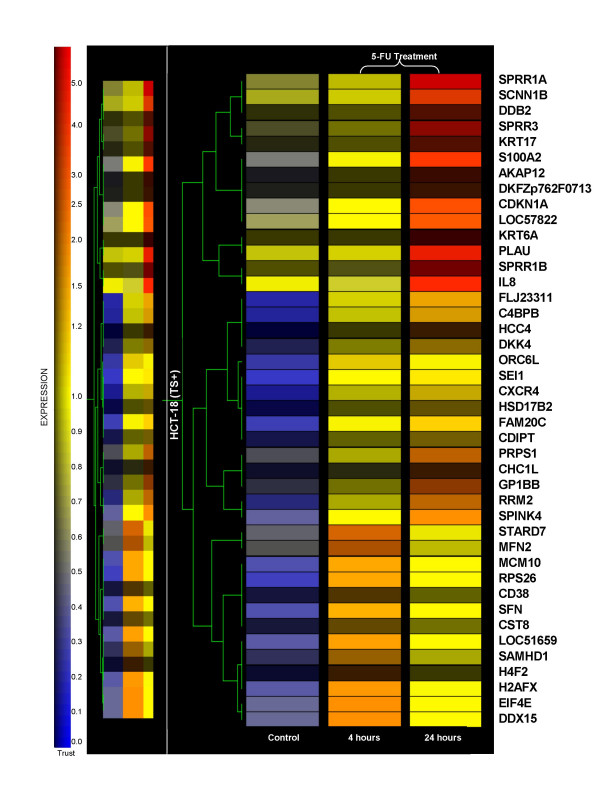
Clustering analysis of TS dependent cytotoxicity in HCT-C18 (TS+) cells (Lane 1) treated with 10 μM 5-FU for 4 hrs (Lane 2) and 24 hrs (Lane 3) based on the expression profiles generated from steady state total mRNAs via One-way ANOVA analysis with p < 0.05.